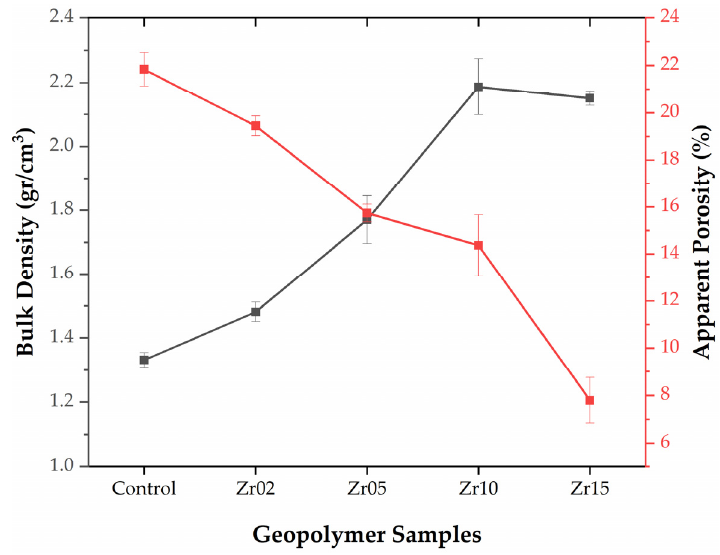
( b ) Figure 6. Scatter diagram of elements in geopolymer samples. ( a ) MZr05 and ( b ) MZr15.